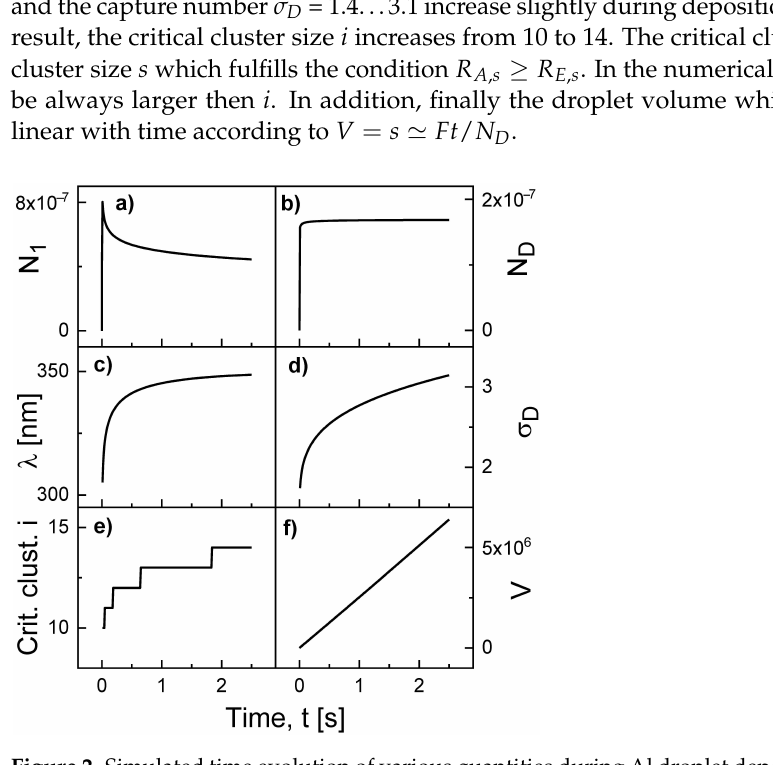
Figure 2. Simulated time evolution of various quantities during Al droplet deposition at F = 0.4 mL/s, deposition time 2.5 s, T = 500 °C, E S = 0.19 eV, and E E = 1.71 eV. ( a ) Monomer density N 1 , ( b ) droplet density N D , ( c ) surface diffusion length λ , ( d ) droplet capture number σ D , ( e ) critical cluster size i , and ( f ) droplet volume V in